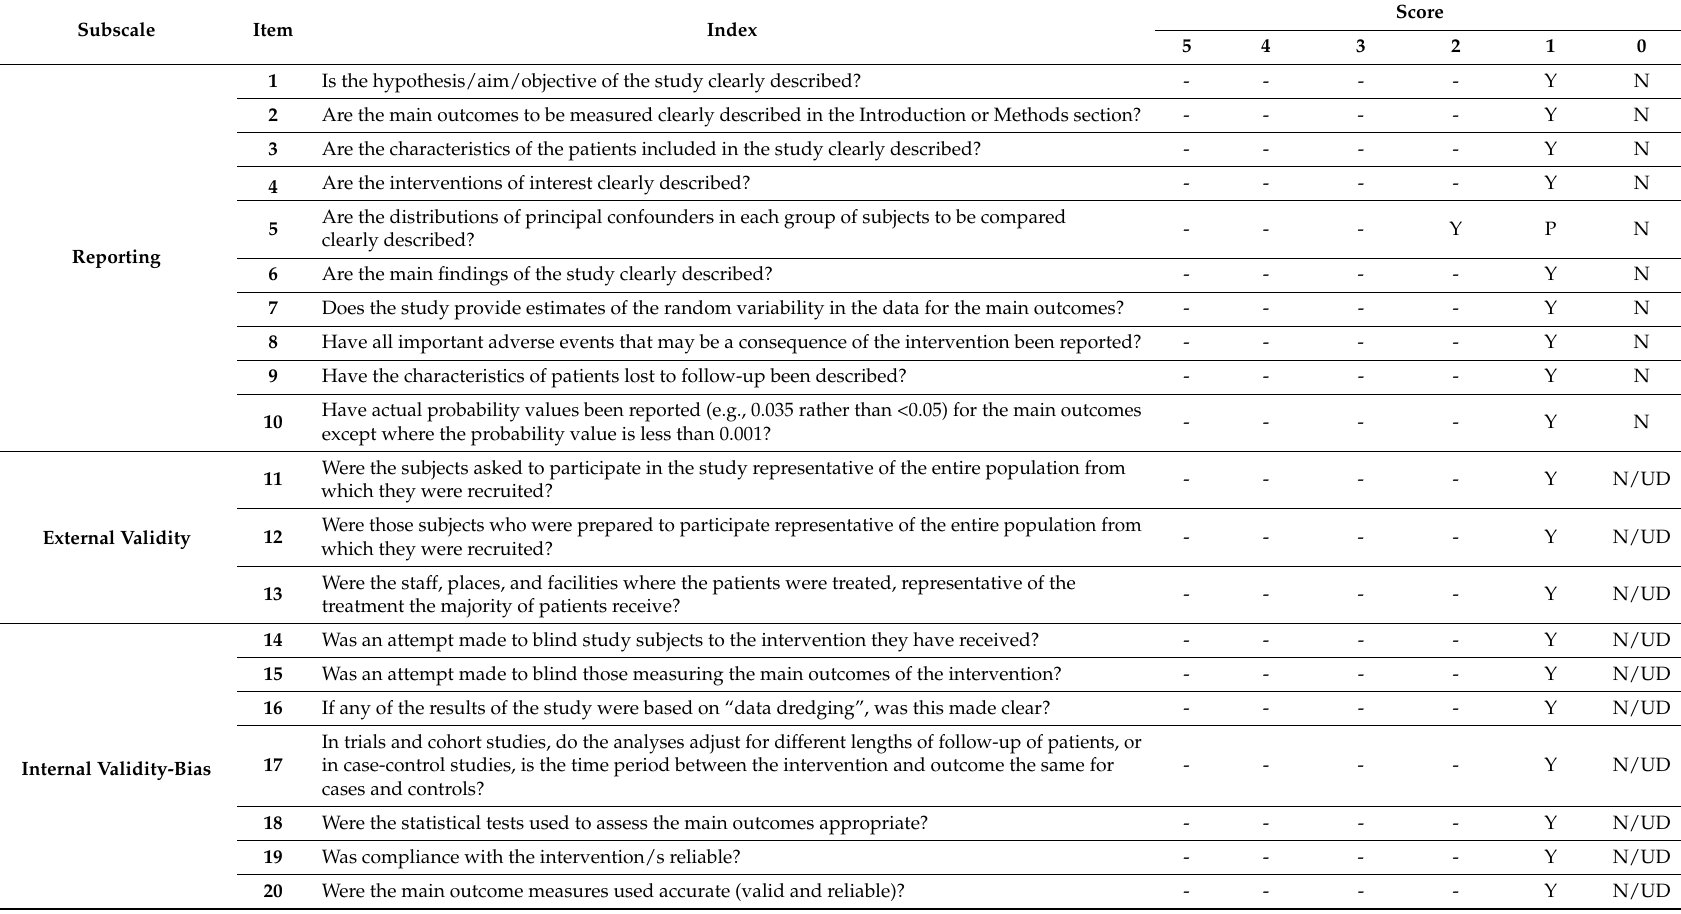
Table 4. The Downs and Black Quality List